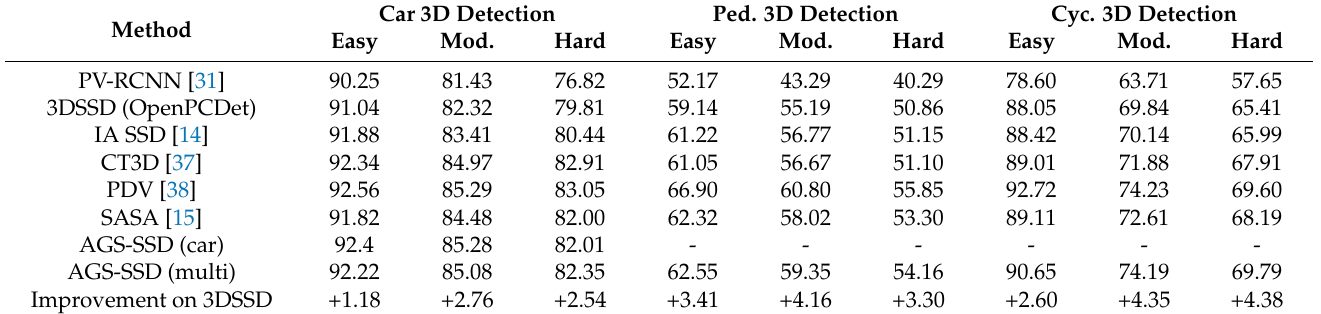
Table 2. Quantitative detection performance achieved by different methods on the KITTI val set.